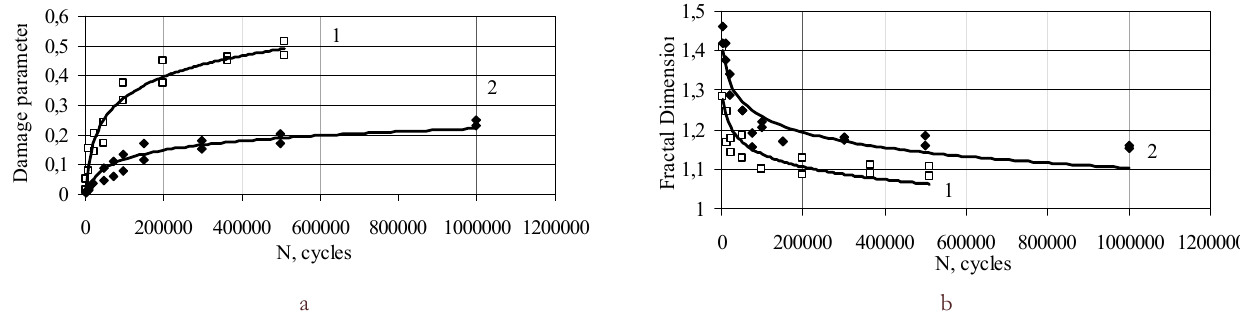
Figure 5: The evolution of the deformation relief, estimated through calculation of damage parameter D (a) and fractal dimention D p /s (b): 1-uniaxial loading; 2-biaxial